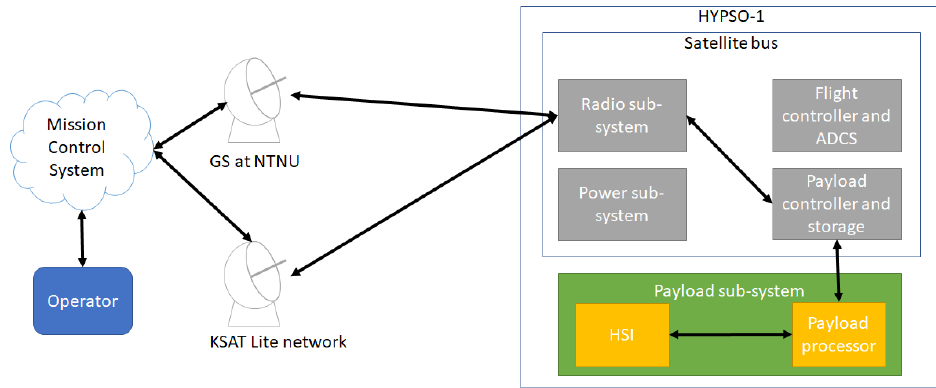
Figure 13. Communications architecture including ground stations for the HYPSO-1